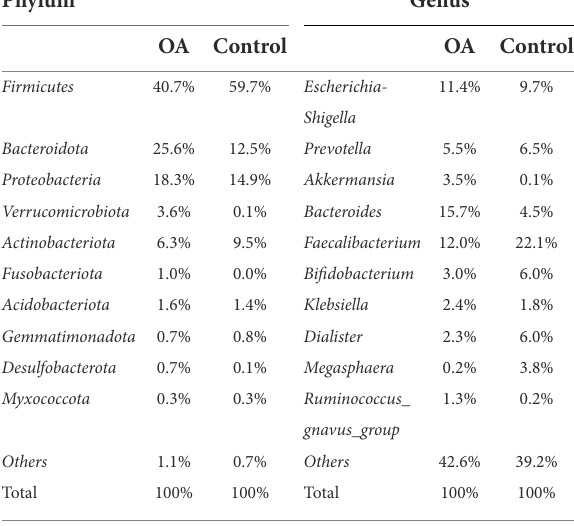
TABLE 2 Relative abundance of top 10 species between groups at phylum and genus